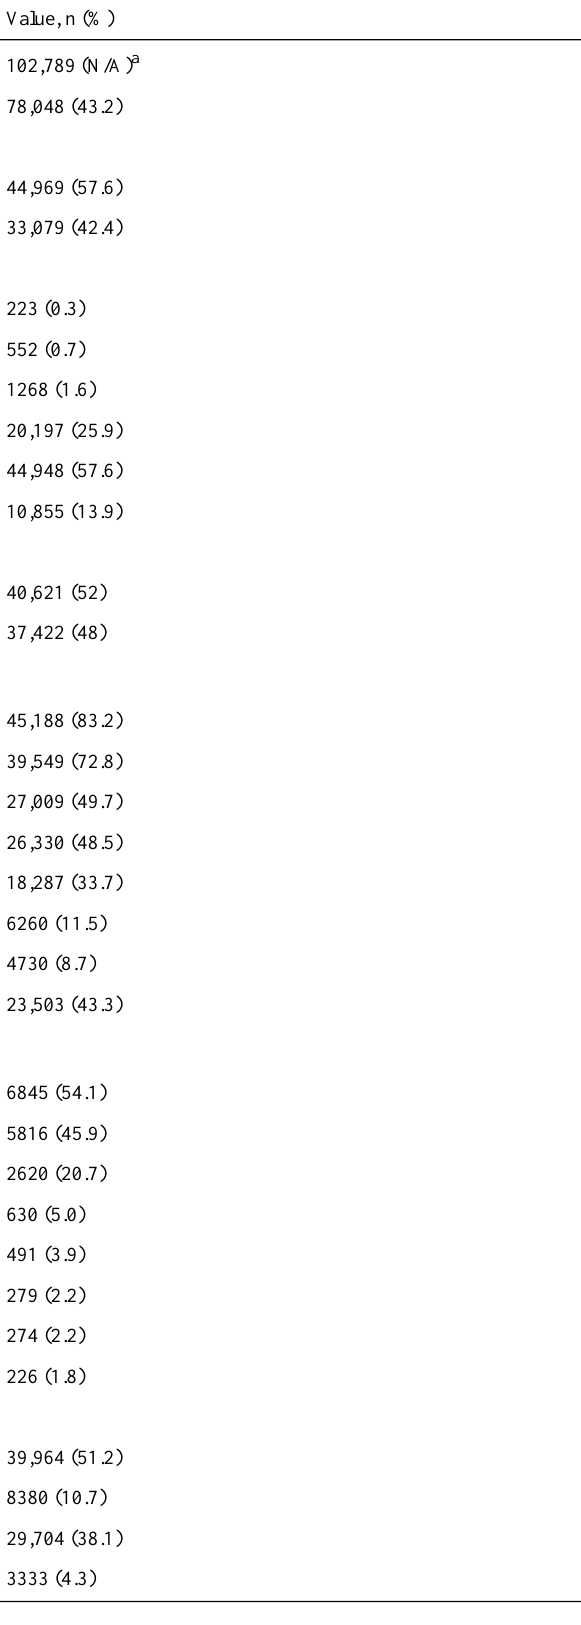
Table 2. Demographic, epidemiologic, and clinical characteristics of patients with confirmed COVID-19, National Egyptian Disease